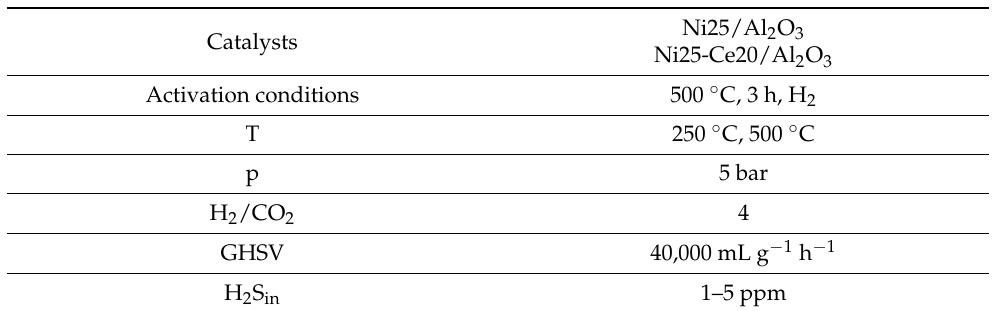
Table 15. Catalysts and reaction conditions for experiments on H 2 S influence on methanation with Ni/Al 2 O 3 and Ce promoter [62].